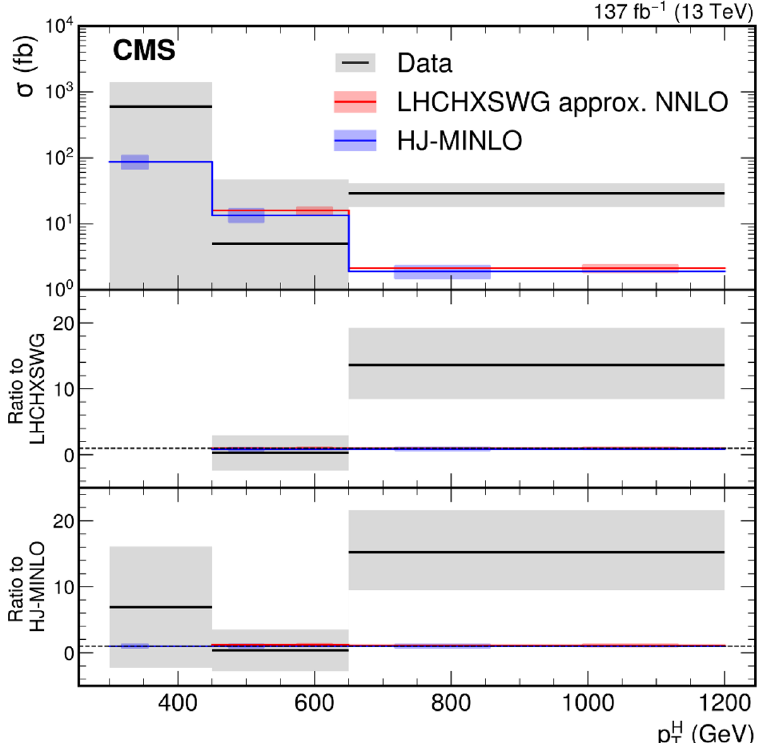
Figure 7 . Measured ggH differential fiducial cross section as a function of Higgs boson p in black, in comparison to the predictions of ref. [33], shown in red, and HJ-MiNLO [32], shown in blue. The two predictions are nearly identical. The larger gray band shows the total uncertainty in the measured cross section while the red and blue hatched bands show the uncertainties in the predictions of ref. [33] and HJ-MiNLO , respectively. In the bottom two panels, the dotted line corresponds to a ratio of one. The relative uncertainties in the predictions of ref. [33] and HJ-MiNLO are approximately 10 and 20%,